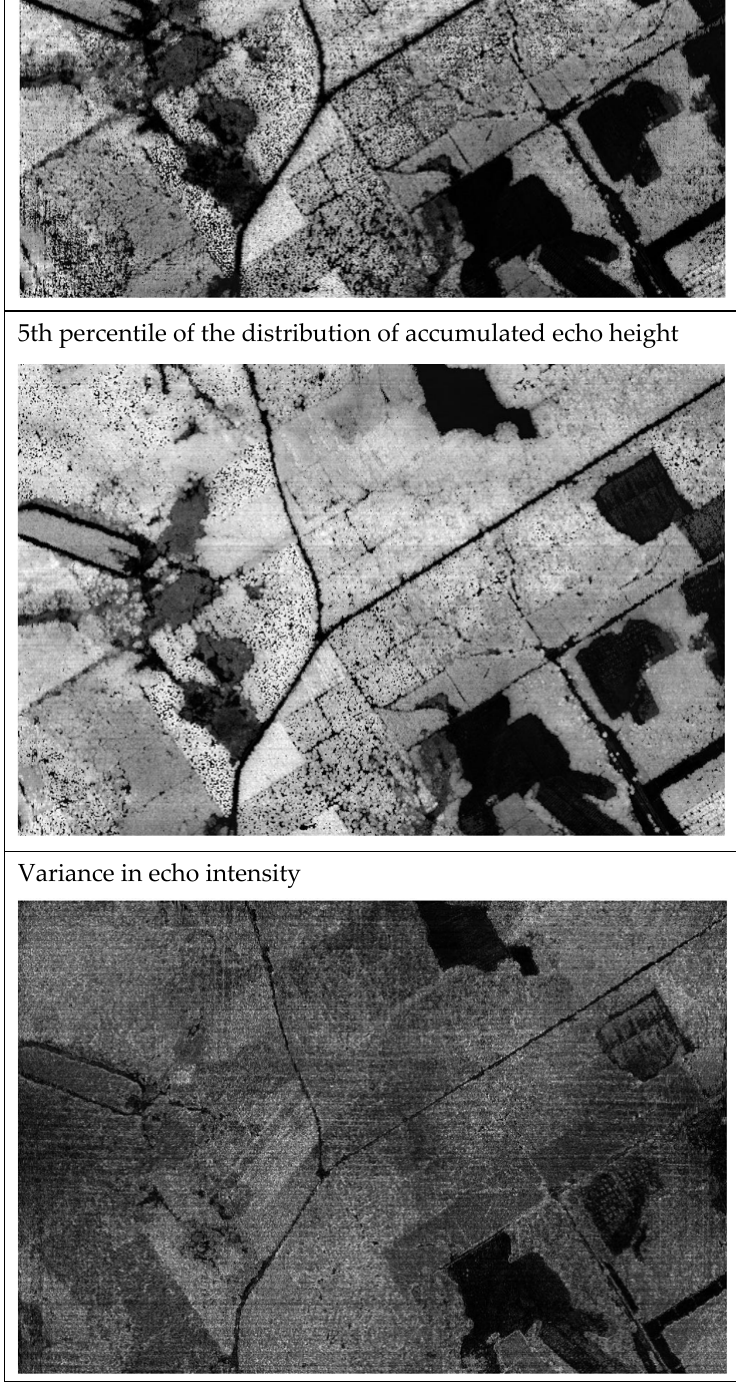
Figure 2. Variation of the LiDAR metrics in 1 m 2 raster cells in a part of sub-area 2. Light tone indicates the high value of the metric.